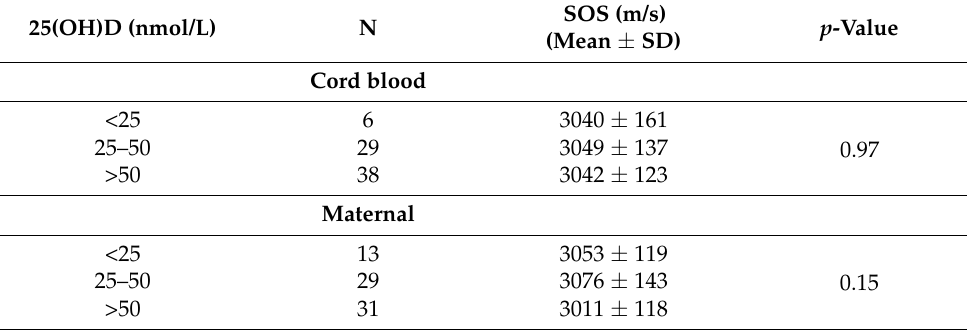
Figure 1. Linear correlation between maternal and cord blood 25(OH)D levels (r = 0.85, p < 0.001). The left tibial SOS measurement was successfully obtained from 74 neonates, with a mean value of 3042 ± 130 m/s. No correlation was found between the SOS measurements and the maternal or cord blood 25(OH)D levels. Accordingly, the mean SOS levels were comparable among the three 25(OH)D groups of maternal and cord blood (Table 2). Table 2. Speed of sound among infants, according to 25(OH)D Table 2. Speed of sound among infants, according to 25(OH)D level.